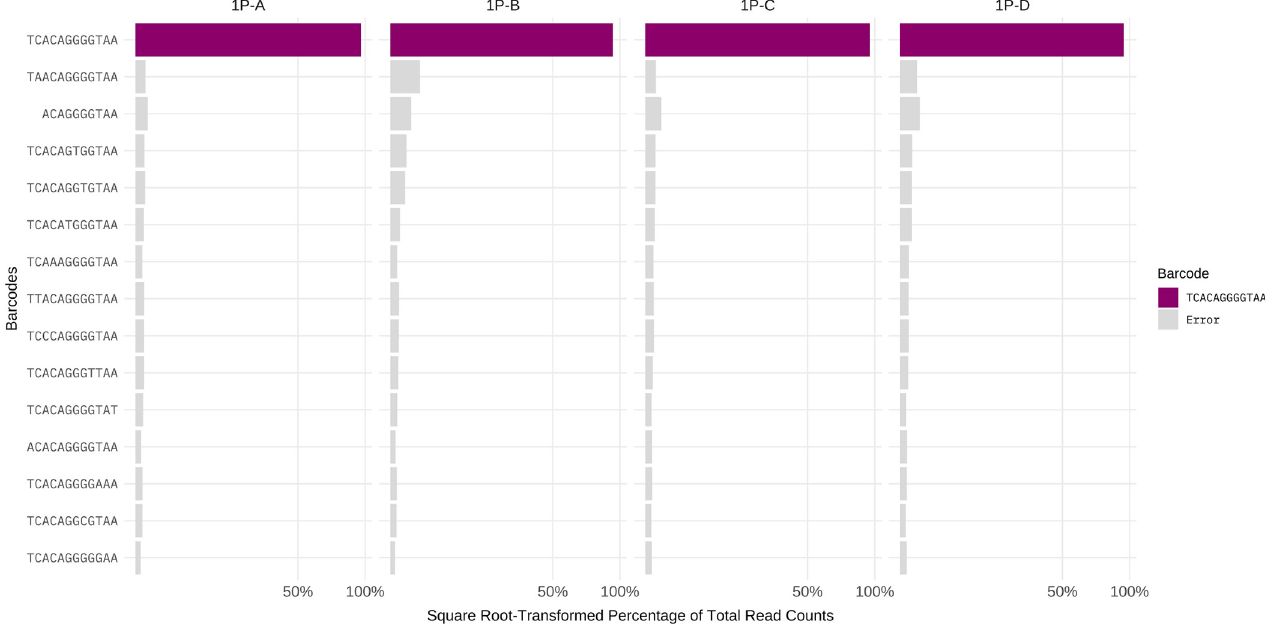
Fig 2. Illumina sequencing reads from single-plasmid controls. The control spiked-in barcode is shown as purple bars, erroneous barcodes are shown as gray bars. Shown are the top highest count 15 barcode sequences tallied across the four 1-Plasmid controls. Raw counts are shown with no clustering applied, with the x-axis square root-transformed to highlight low